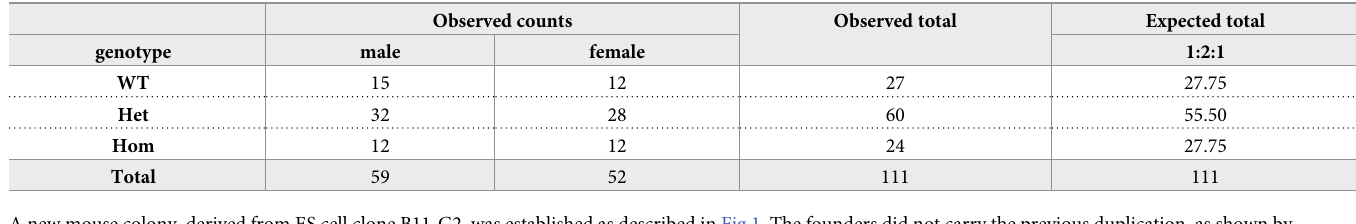
Mendelian 1:2:1 distribution, with the expected number of homozygotes, P =